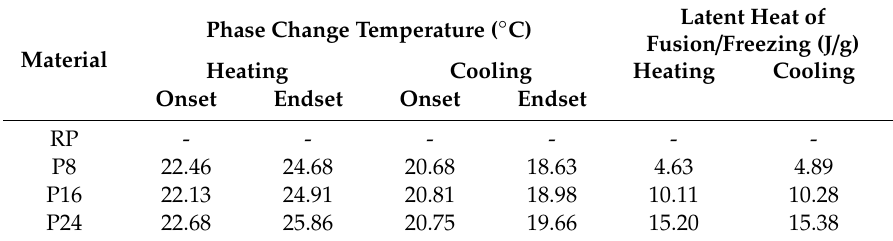
Table 1. Phase change temperatures of studied plasters and specific enthalpies.